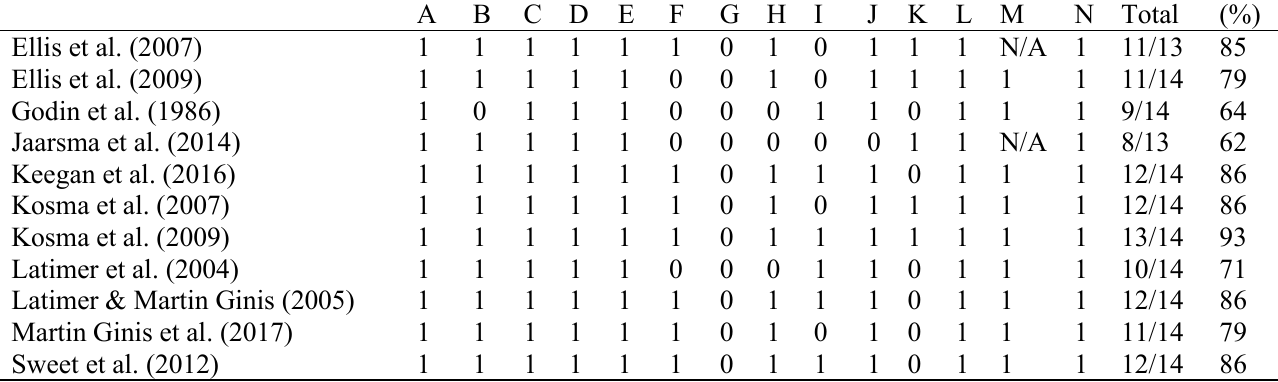
Table 3 . Quality Ratings of Included